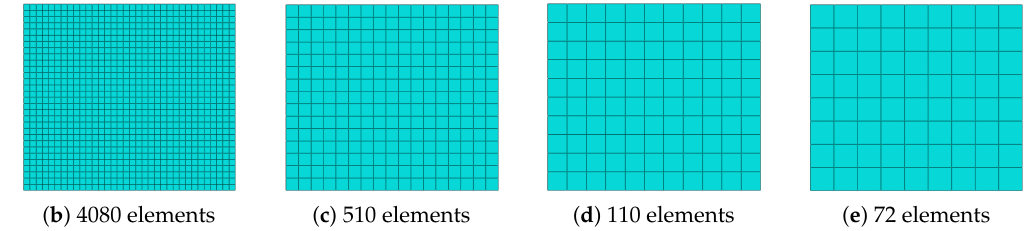
Figure 10. Mesh sensitivity analysis with different mesh sizes and element numbers: ( a ) 25 mm; ( b ) 50 mm; ( c ) 100 mm; ( d ) 150 mm; ( e ) 200